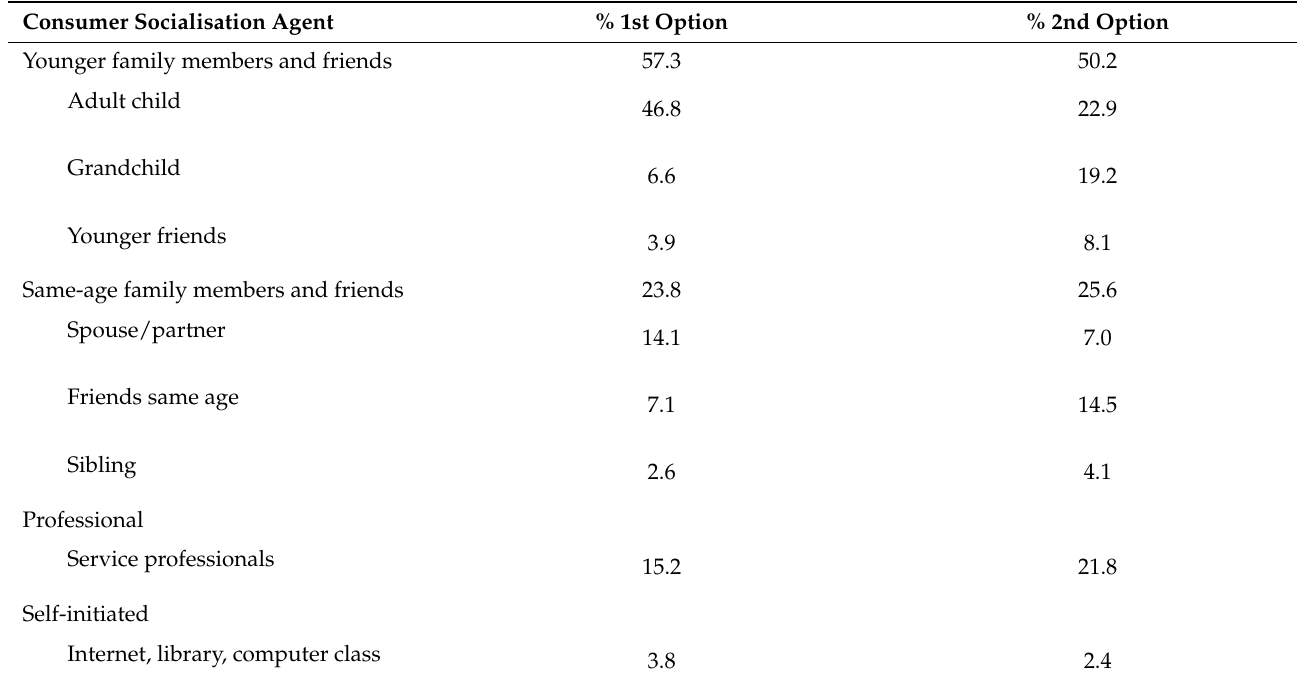
Table 1. Preferred 1st and 2nd options of socialisation